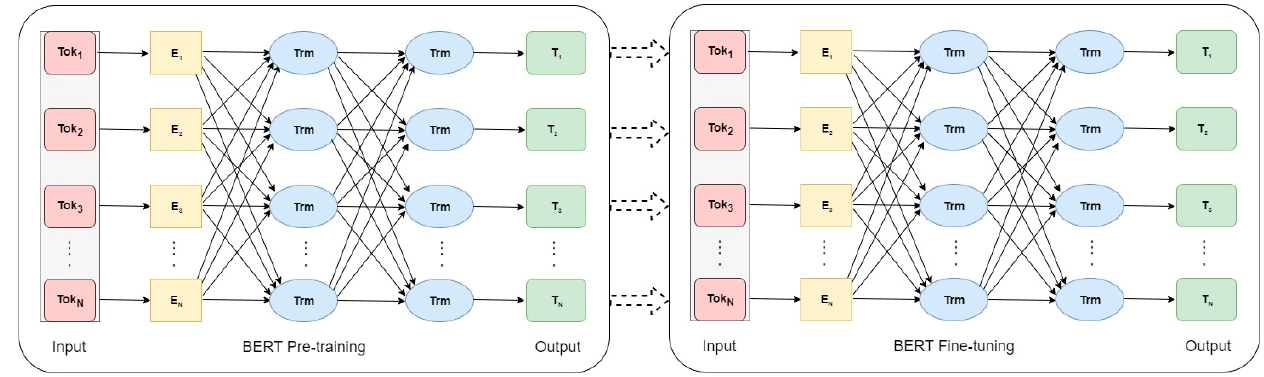
Figure 14. Pre-training and fine-tuning procedures for BERT [116].